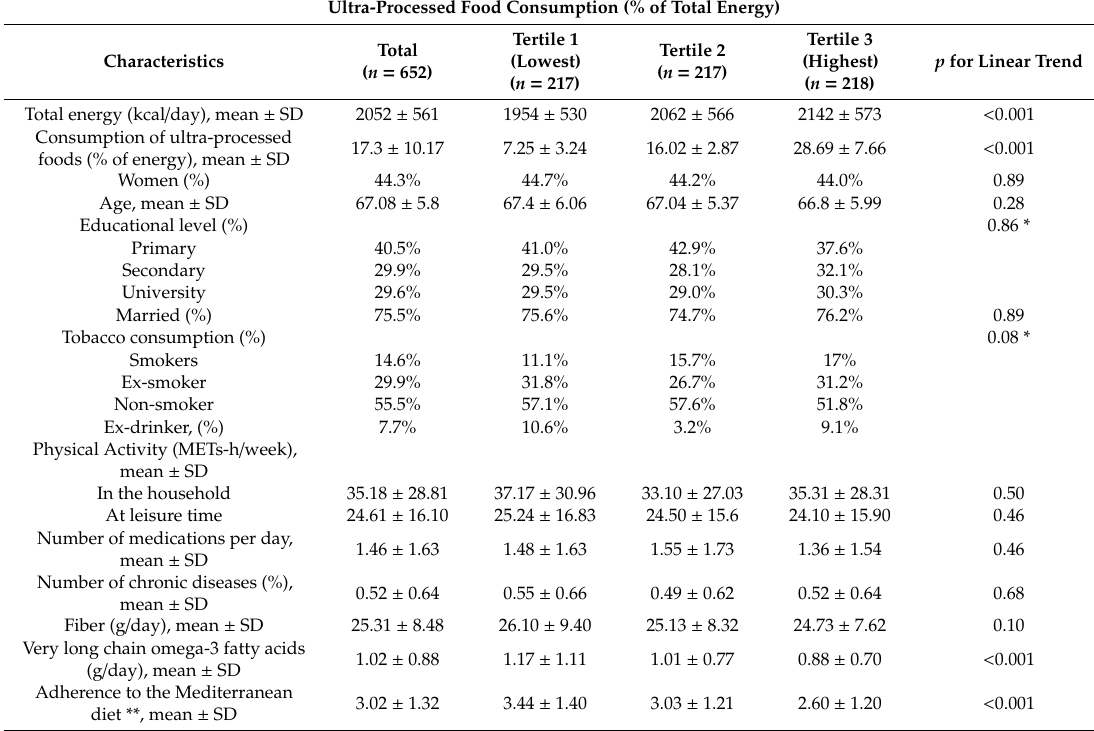
Table 1. Baseline sociodemographic and lifestyle characteristics of participants according to sex-specific tertiles of ultra-processed food consumption (% of energy) in the Seniors Study on Nutrition and Cardiovascular Risk in Spain: Seniors-ENRICA 1 Study (2008–2010).